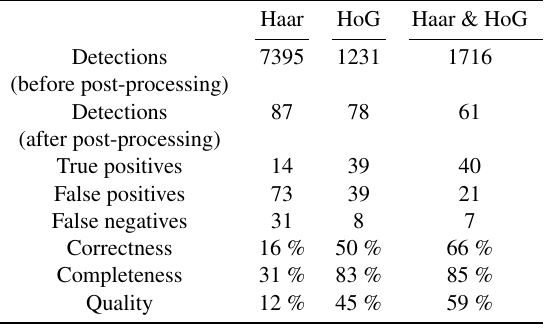
Table 4: Statistics of